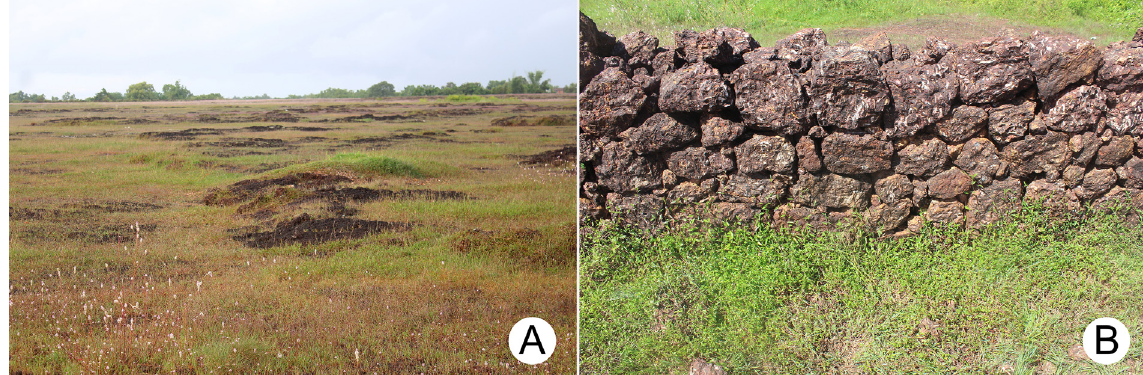
Fig. 6. Madayipara, Kannur, Kerala, type locality of Trichrysis poseidonia sp. nov. A . Madayipara, laterite plateau. B . Collecting place on dry